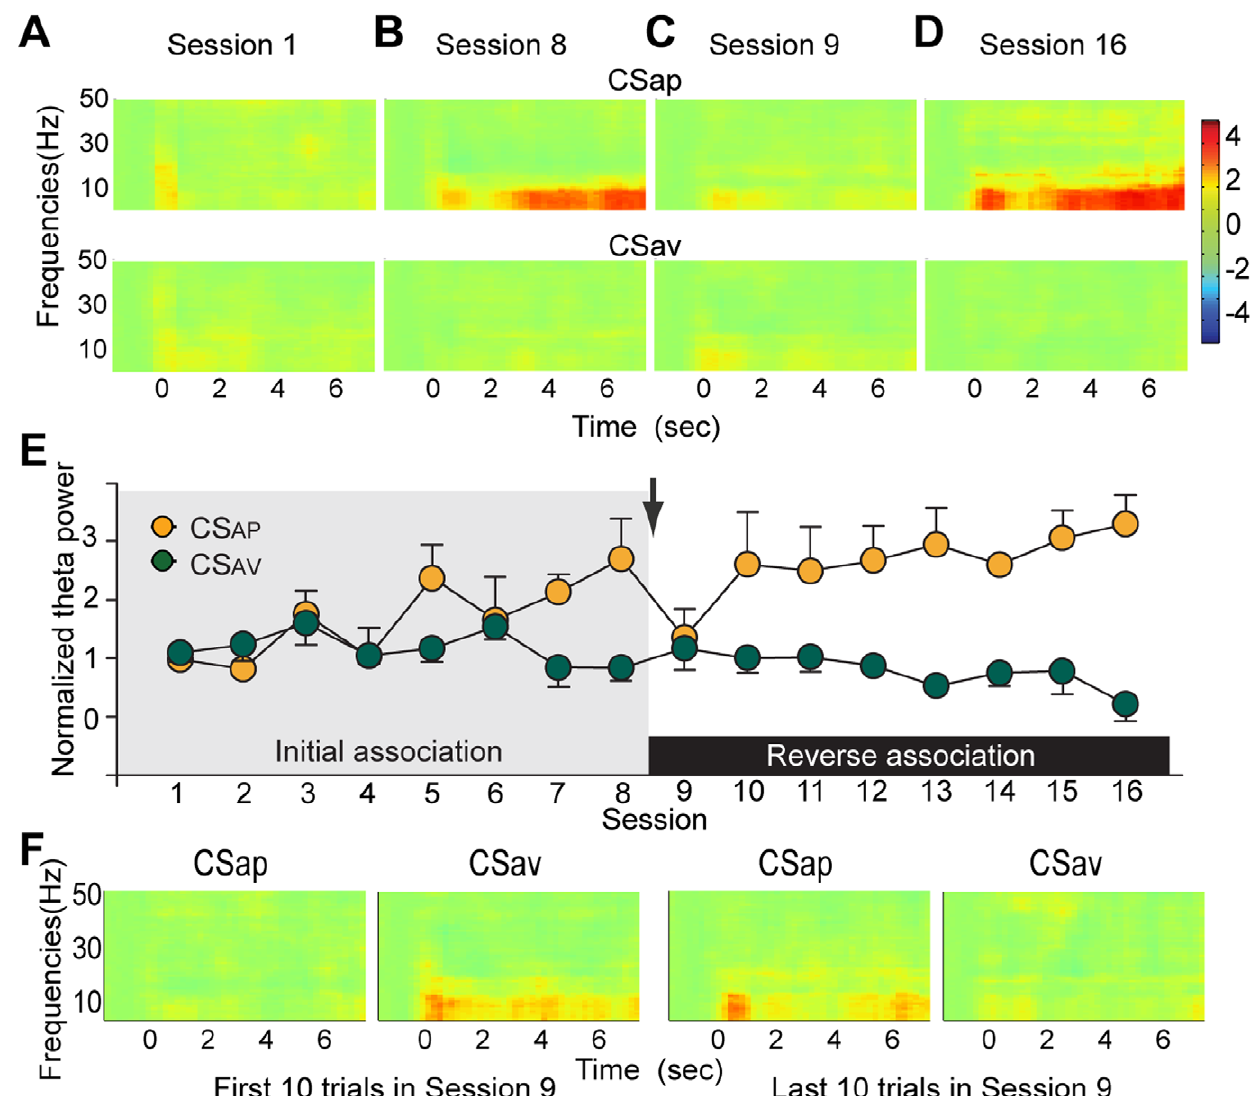
Figure 4. Change in LFP power pooled across subjects. ( A–D ) Spectrograms aligned to CS AP and CS AV and data depict group average baseline ( 2 1.5–0 sec before CS) normalized power per frequency bin according to the color scale at the right. Frequencies between 0.7 and 50 Hz are displayed with top row representing CS AP and bottom row representing CS AV . ( E ) Change in theta power (4–8 Hz) during a 4 second window aligned to each CS onset. Data are depicted as mean + SEM in each session. The initial associations (pre-reversal) were presented during sessions 1–8 and are depicted with the grey background. The reversed association was presented during session 9–16 and is depicted with the white background. The arrow marks the reversal and the color legend is depicted in the upper left corner. As the most prominent changes in LFP oscillations were in the theta range, we more closely examined the normalized power of theta band oscillations. ( F ) Changes in LFP power within the session 9. Data in each spectrogram are depicted as the average over the first 10 trials. Similar format and same color scale as (A–D). The CS AP and CS AV were reversed in session 9. Spectrograms of the first 10 trials of CS AP and CS AV delivery showed opposite patterns as the pre-reversal sessions, indicating that power modulations were not tracking the reversal in associations (left). In the last 10 trials, the new CS AP evoked an increase in power while the new CS AV modulated power in a similar fashion as pre-reversal sessions, indicating the power modulations were now tracking the reversal of associations.